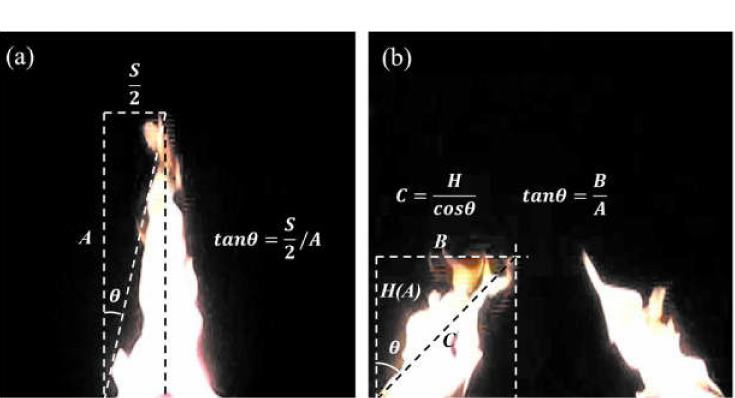
Figure 6. Schematic diagram of flame tilt angle and length definition: ( a ) flame merged and ( b ) flame not merged.